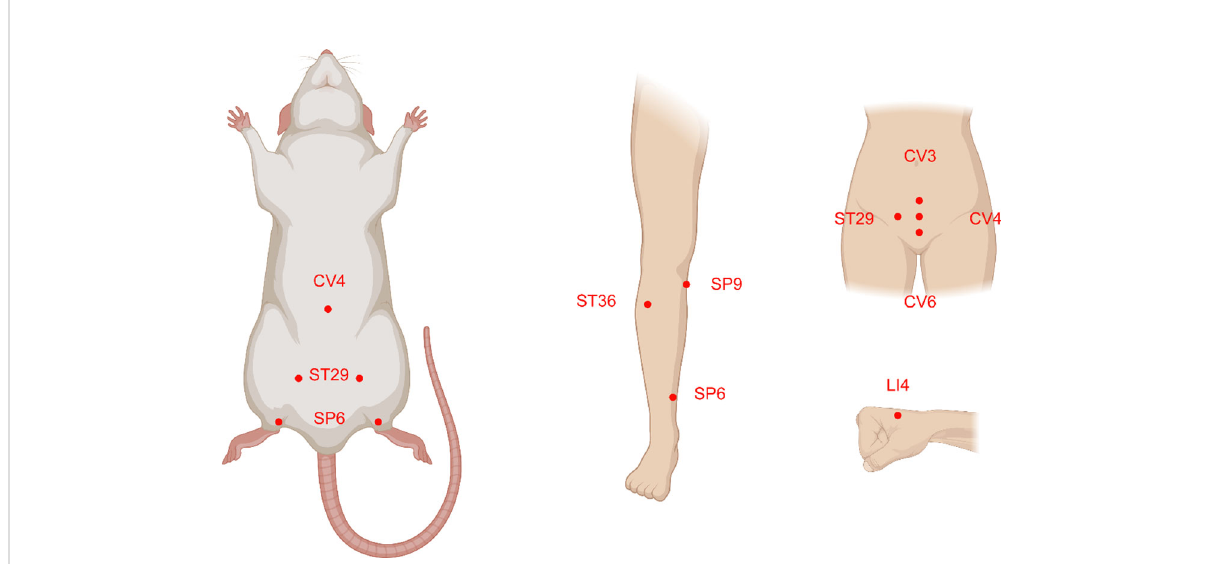
FIGURE 5 The acupoints common selected and their location distributions in animals and humans with polycystic ovary syndrome (PCOS). The majority of the acupoints are located on the abdomen, upper and lower